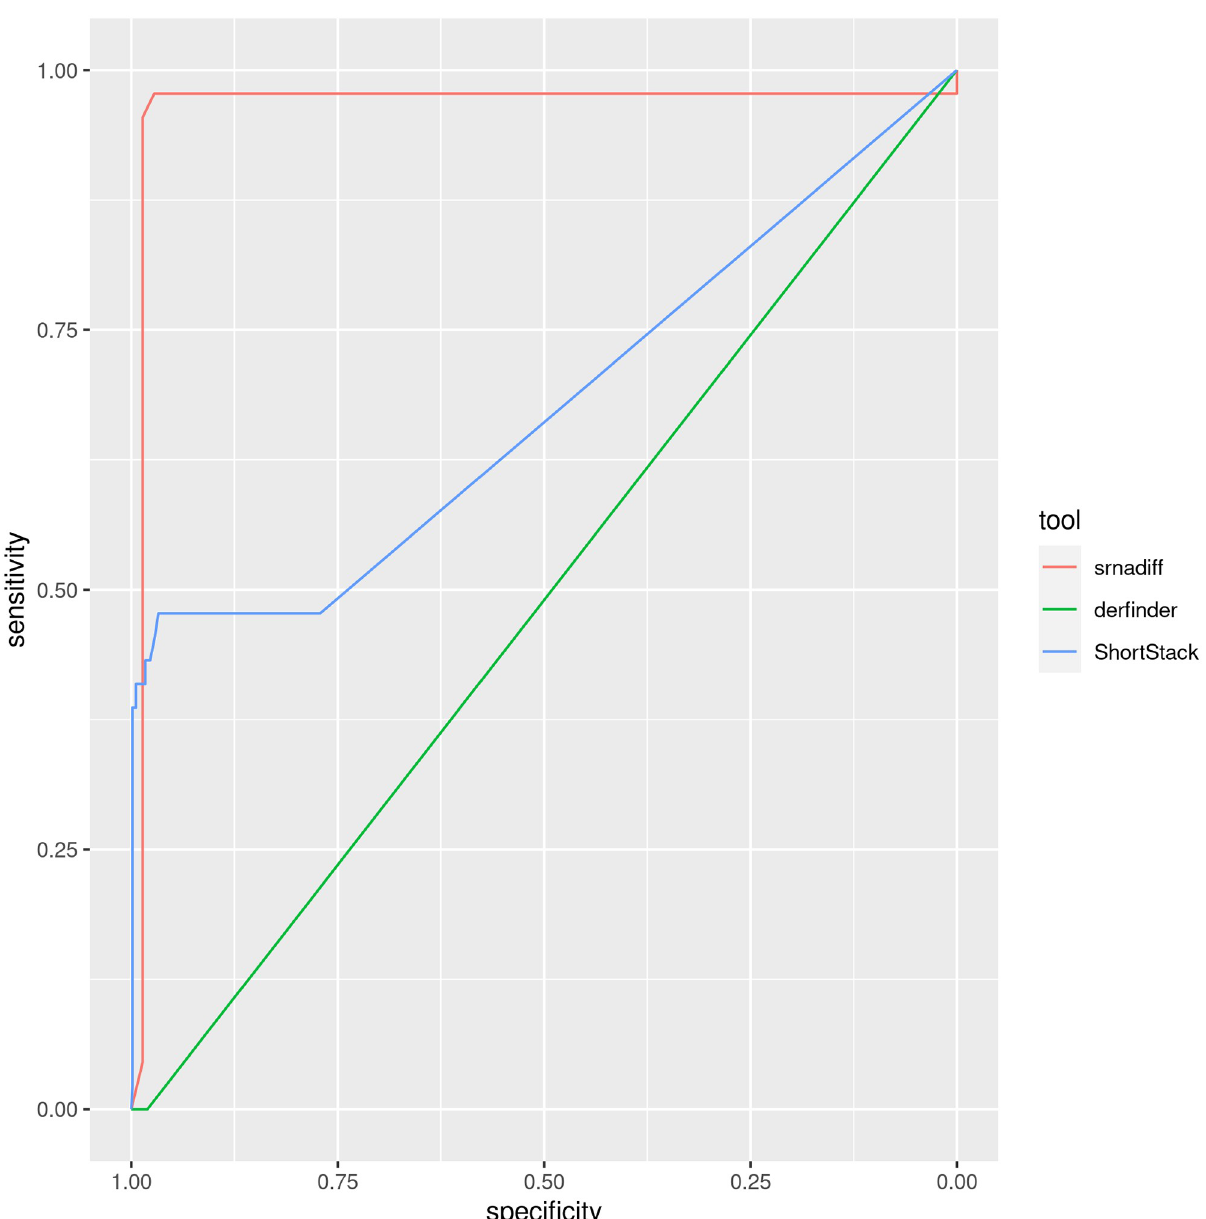
Fig 7. Results on the synthetic dataset. The areas under the curves (AUC) of the receiver operating characteristic (ROC) curves of srnadiff, derfinder, and ShortStack are respectively 0.9639, 0.5098, and 0.3235. The (unfiltered) number of candidates for each tool is 72, 60, and 720.